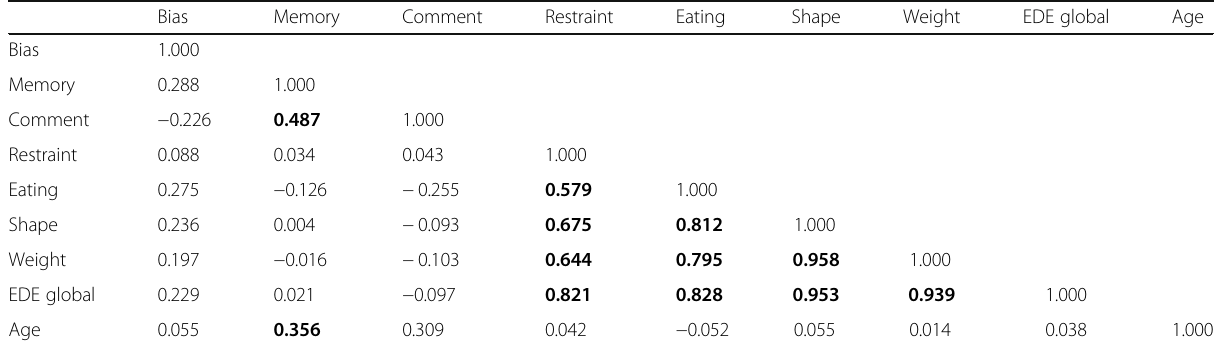
Table 7 Experiment 1: bivariate correlations between person-level covariates of age and Eating Disorder Examination Questionnaire subscales and global scale, as well as correlations with model-derived by-person estimates for response bias, memory, and the effect